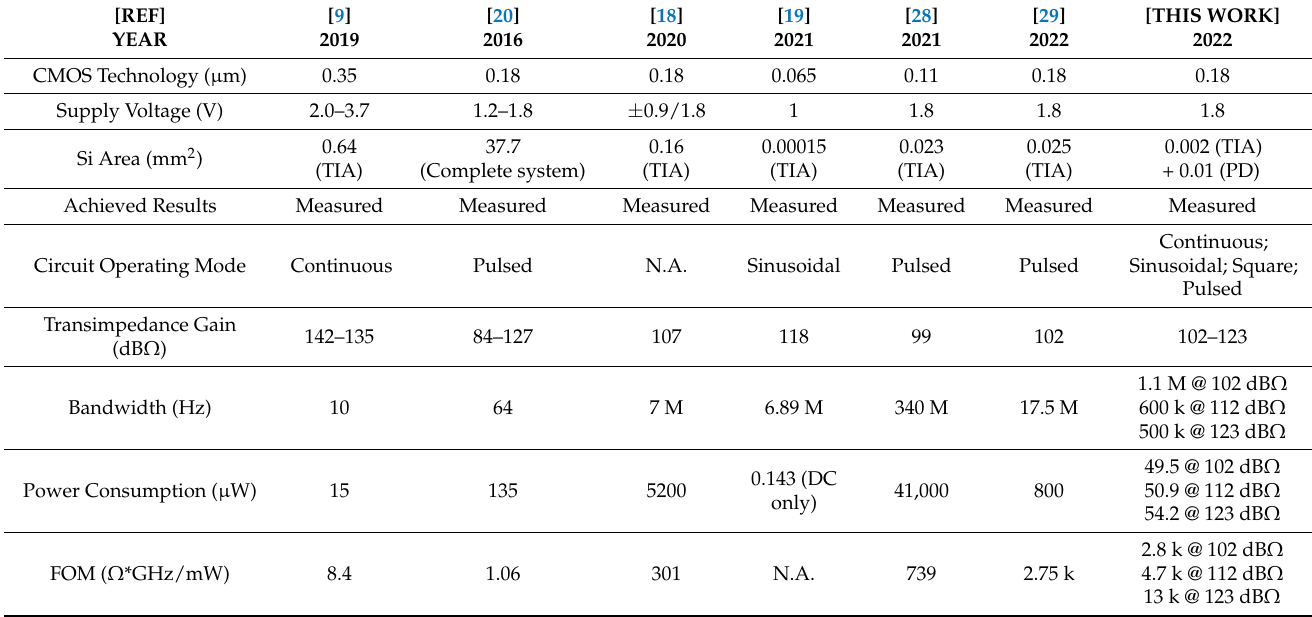
Table 2. Main circuit measured characteristics and its comparison with the